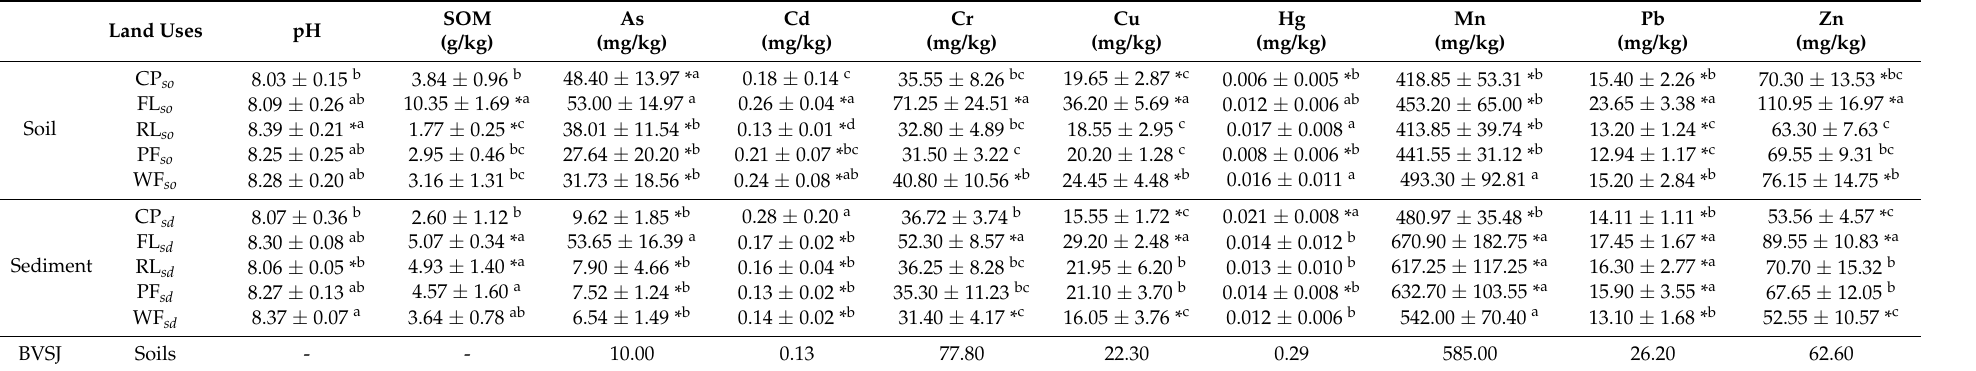
Table 3. Metal concentrations together with the pH and SOM in surface soils and its corresponding sediments under different types of land